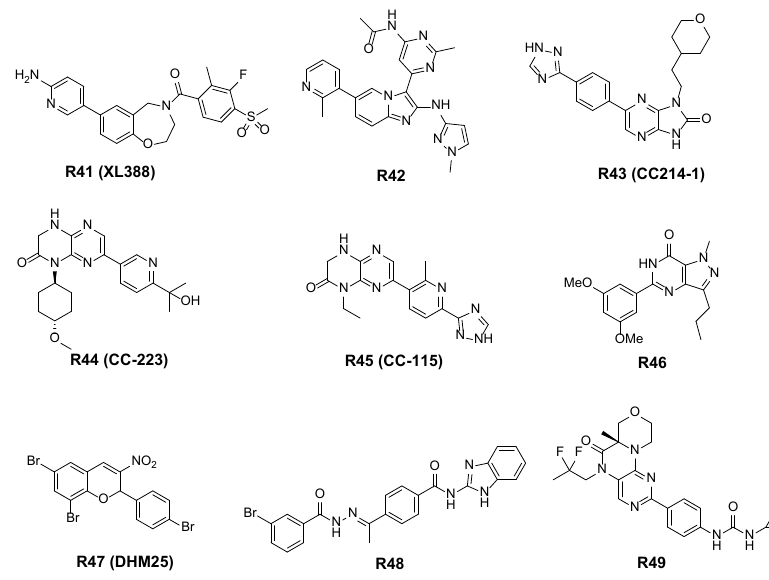
Figure 7. Structures of other structural skeletal inhibitors.